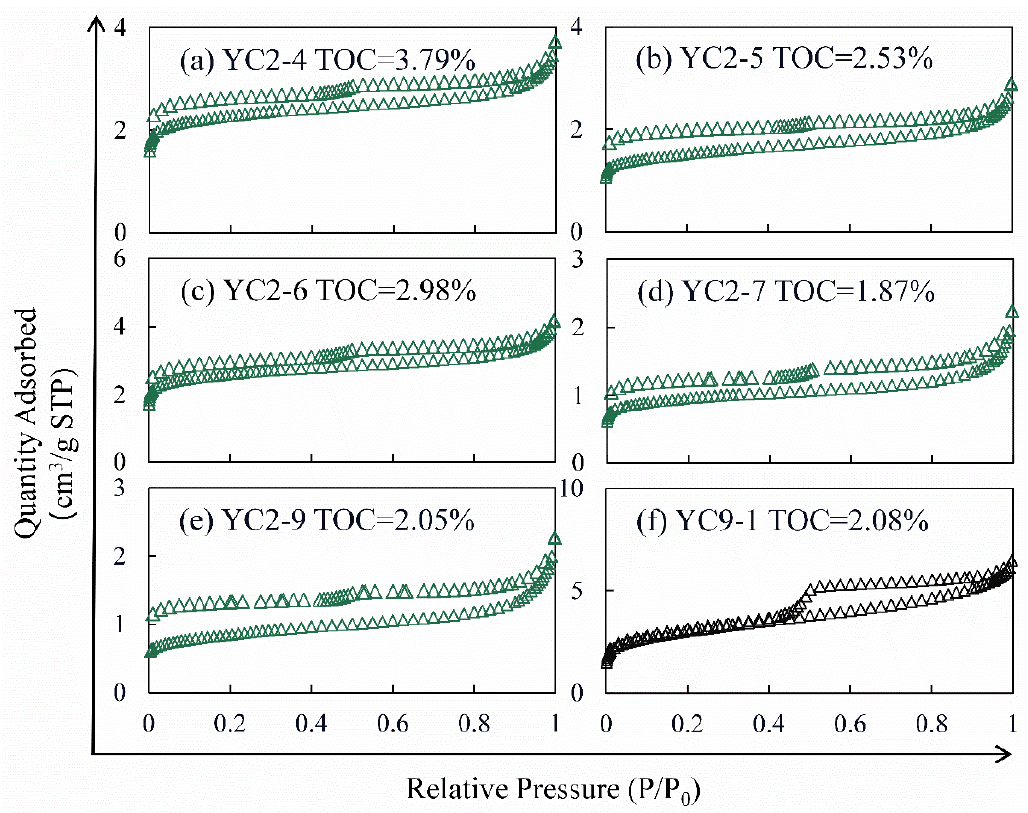
Figure 7. LPNA curves of selected shale samples with different TOC. All samples from well YC2 have a LPH, while sample YC9-1 does not.